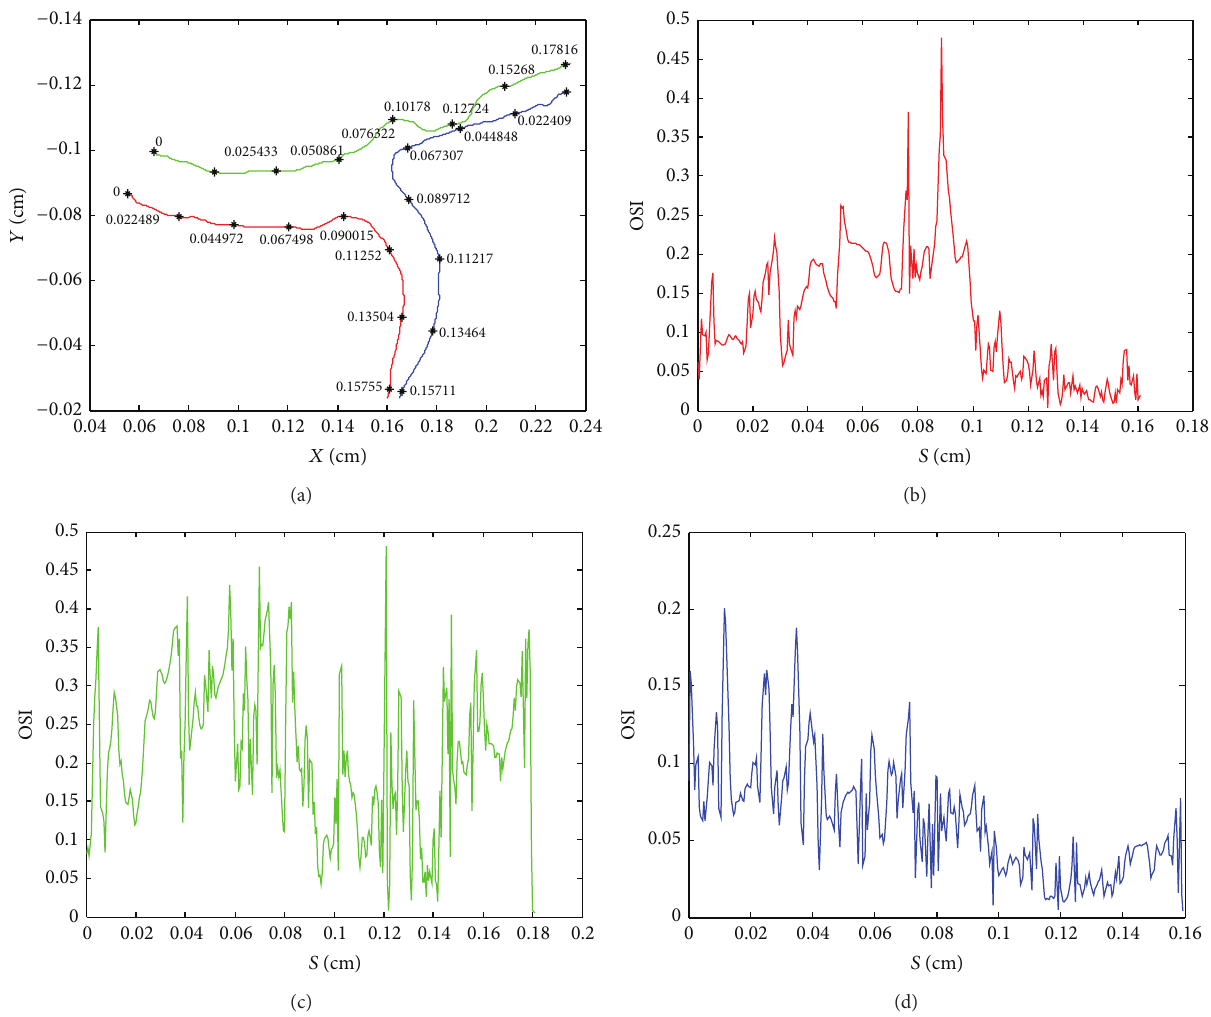
Figure 6: (a) Boundary plots of the coronary arterial walls 1, 2 and 3 shown in red, green, and blue, respectively. (b)–(d) OSI distribution along coronary walls 1, 2, and 3,